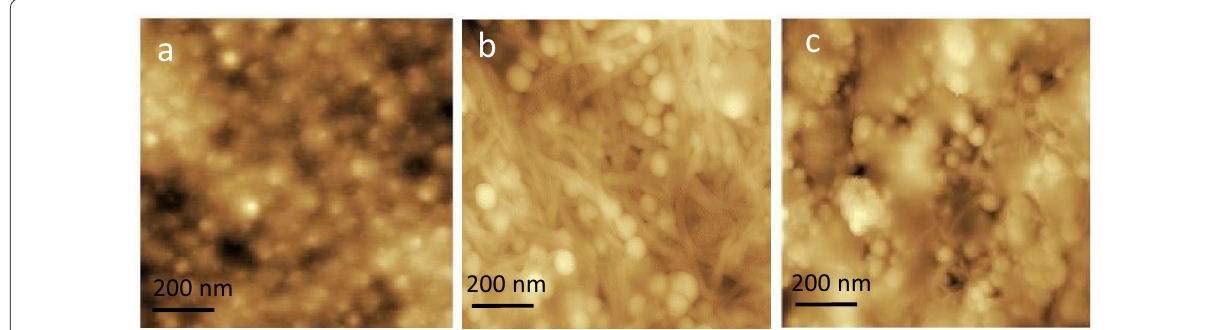
Fig. 3 Atomic force microscopy images of acryl films with and without CNF. Acryl resin film ( a ) and CNFs/acryl resin composite film ( b ) on a mica substrate and the composite film applied to a wood board with a spray-type coating apparatus ( c